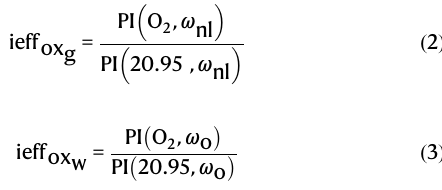
35% vol. O 2 ( a ) and total global 10-year averages of rate of fi re spread over varying atmospheric oxygen levels for different bands of fuel moisture content ( b